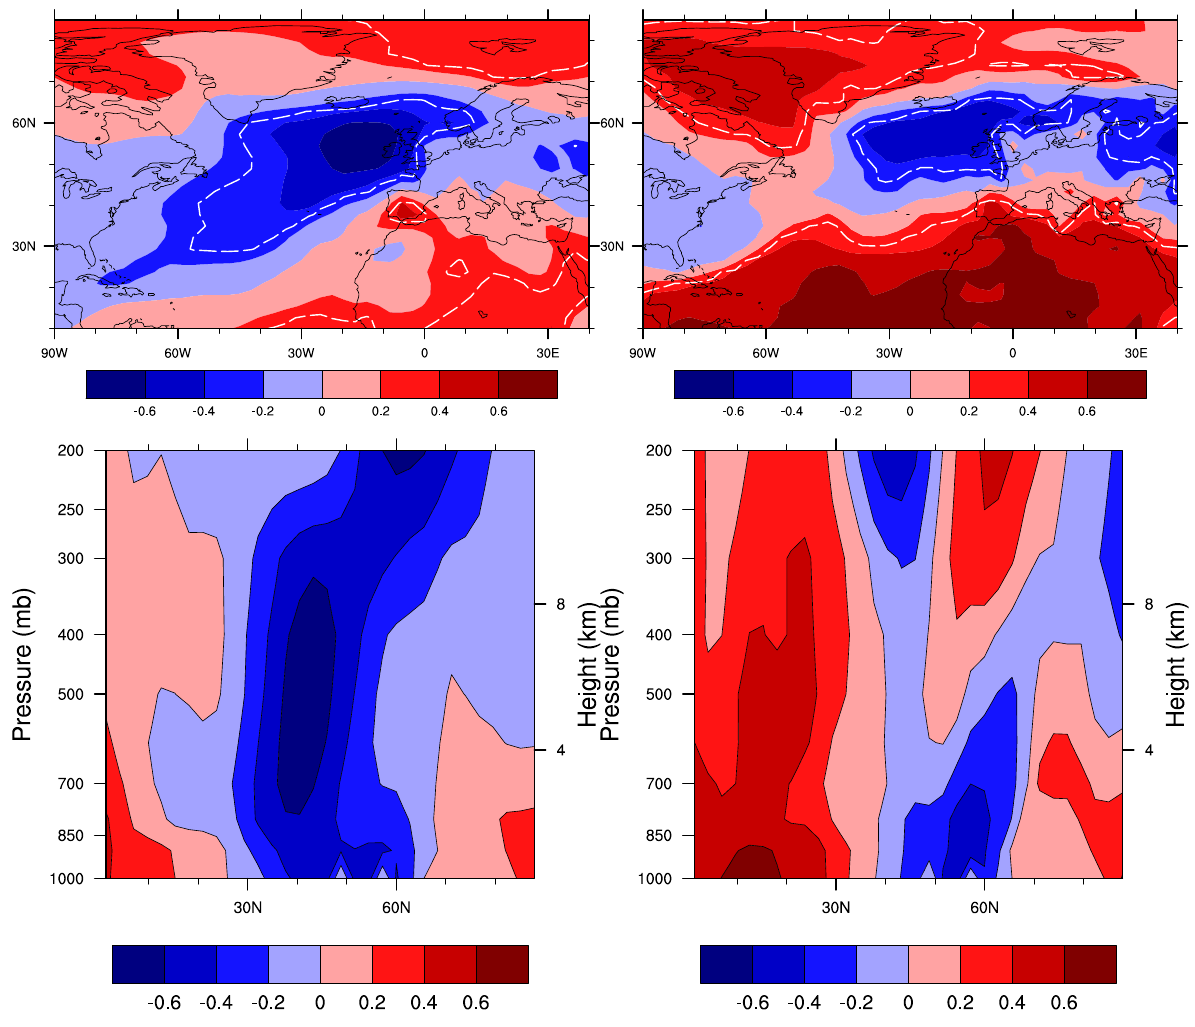
Fig. 8. Correlation of winter (December-February) seasonal surface concentration anomalies (top) and meridional vertical profiles at 30 ◦ W (bottom) with the principal component of the EOF time series of SLP in the North Atlantic sector for gaseous tracers (left) and soluble aerosols (right) emitted from Europe. White dashed contour lines indicate the local 95% level of